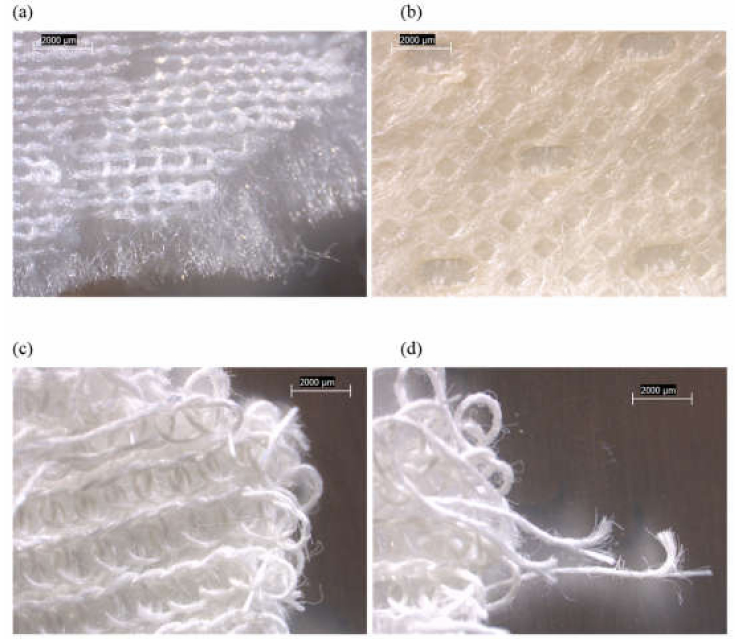
Figure 4. Low-power reflected-light stereozoom microscope images of FG-3 mattress subsamples acquired at 10 × . ( a ) White, synthetic, woven outer cover material from top side of mattress. ( b ) Beige outer cover material from bottom side of mattress consisting of synthetic fibers in polymeric binder. ( c ) Inner sock material, showing woven threads, each uniformly wrapped in white synthetic fibers. ( d ) Same as ( c ), but inner fiberglass core revealed inside each